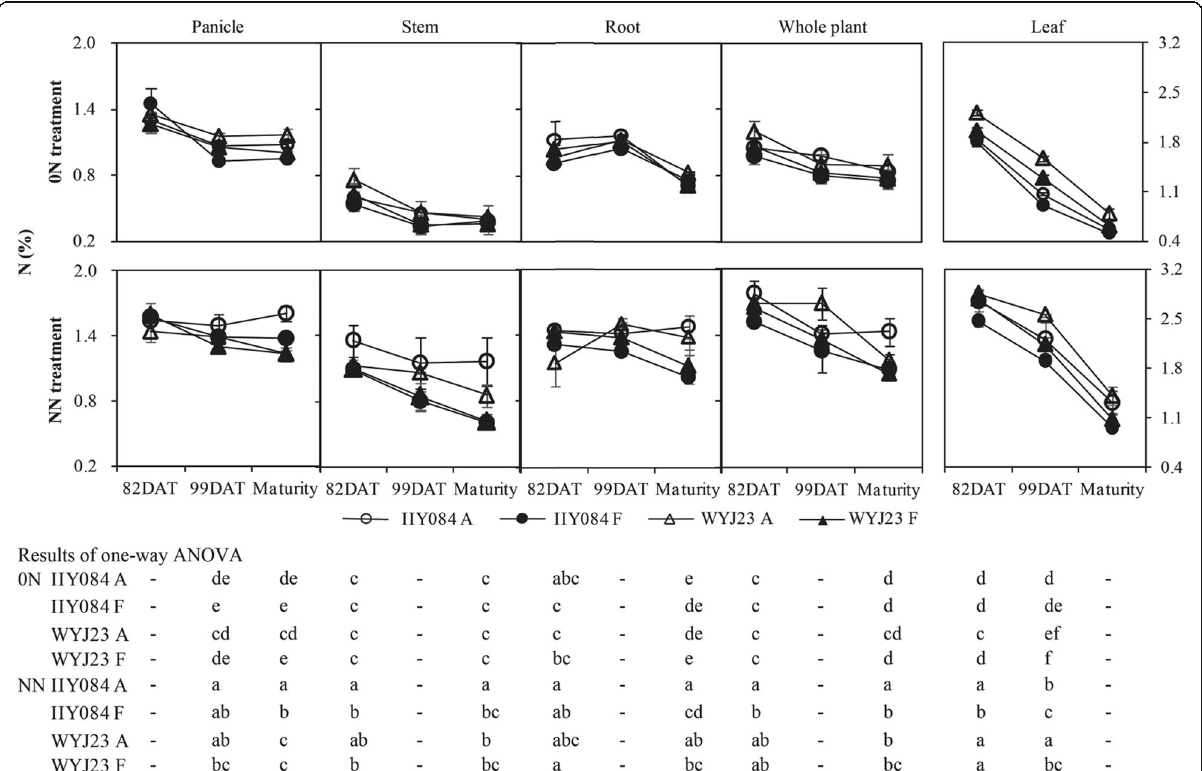
Fig. 1 N concentrations in four tissues and whole plants of two cultivars (IIY084 and WYJ23) subjected to ambient (A) and elevated [CO 2 ] (F) at none (0N) and normal N levels (NN) at three stages (different letters in each column represent significant differences in each tissue among eight treatments at each sampling date according to LSD at 5% level. -; one-way ANOVA was not applied because no significant interactions of [CO 2 ], cultivar, and N were